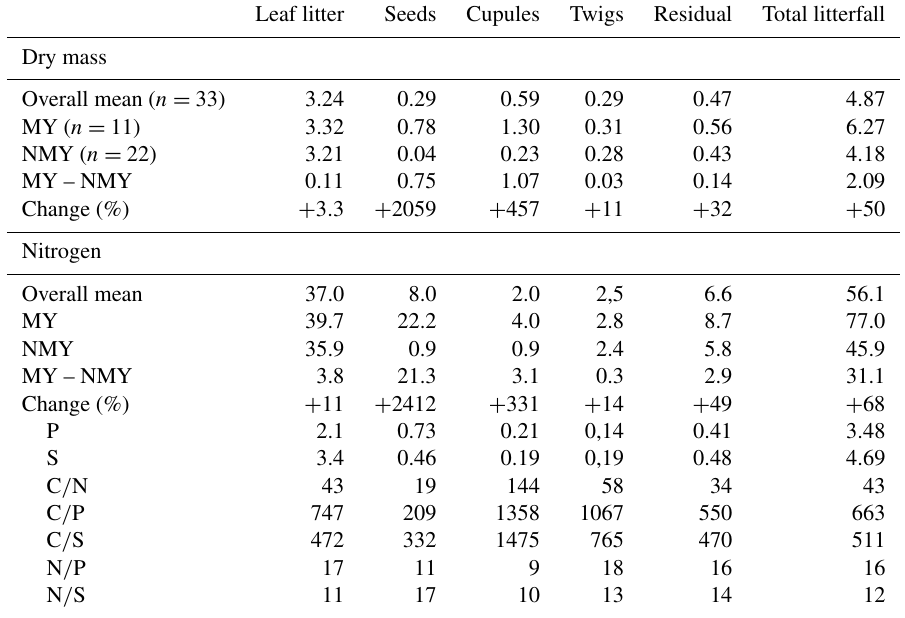
Table 4. Annual means of dry weight (Mgha − 1 ), nitrogen (N), phosphorous (P), and sulfur (S) (kgha − 1 ) of litter fractions (leaf litter, seeds, seed cupules, twigs, total litterfall, and a fraction of small pieces which were not separated (residual)), and the ratios of the elements at three European beech ( Fagus sylvatica L.) stands in Rhineland-Palatinate from 1995–2005 (Neuhäusel Bims, NHB; Kirchheimbolanden, KHB; Neuhäusel Quarz, NHQ). For the dry mass and nitrogen, additional means are listed for years with mast (MY) (full- and half-mast), non-mast years (NMY), and the difference between mast and non-mast years. The changes of dry mass and N of litter fractions and total litterfall in mast years compared to non-mast years are given in percent.